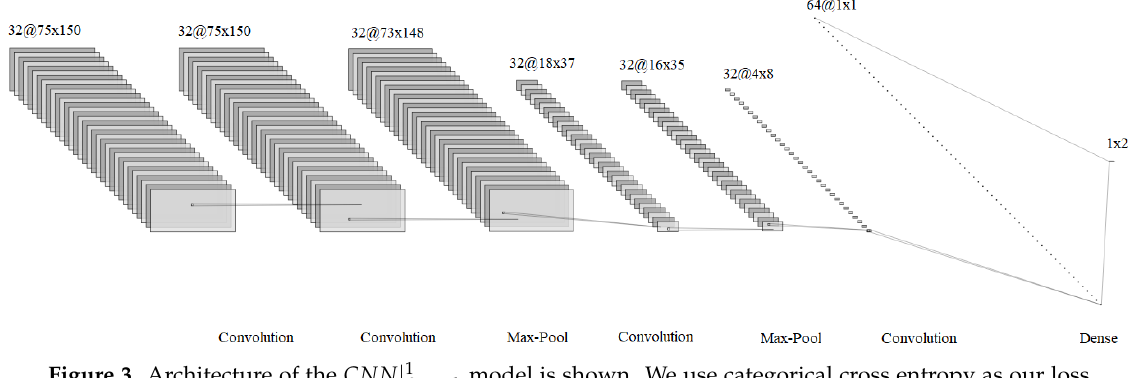
Figure 3. Architecture of the CNN | 1 model is shown. We use categorical cross entropy as our loss Scratch function. We also use SGD as our optimizer. After the first convolution layer, the dimensions were not reduced because of zero padding (which is why the dimensions remain the same). It allows for our network to operate in more coarse scale (inspired by [45]).